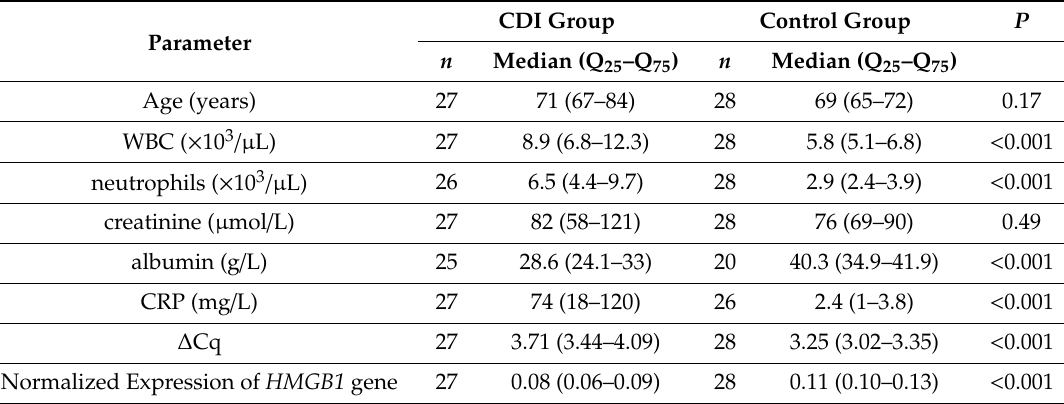
Table 1. Results of the assessed parameters in the study